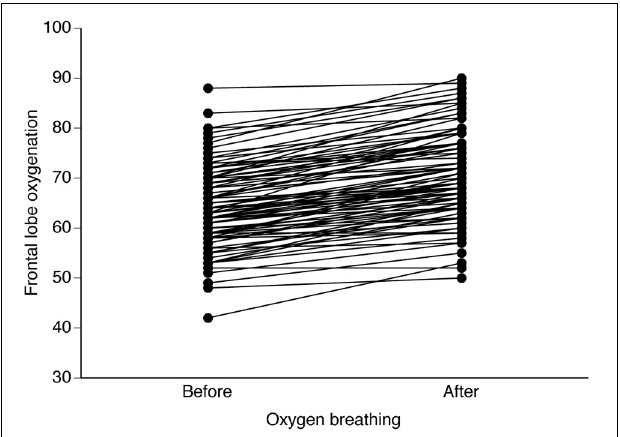
FIGURE 1 | Effects of O 2 breathing on NIRS determined frontal lobe oxygenation. Data are individual responses from vascular surgical patients exposed to preoperative facial mask breathing with 100% O 2 .